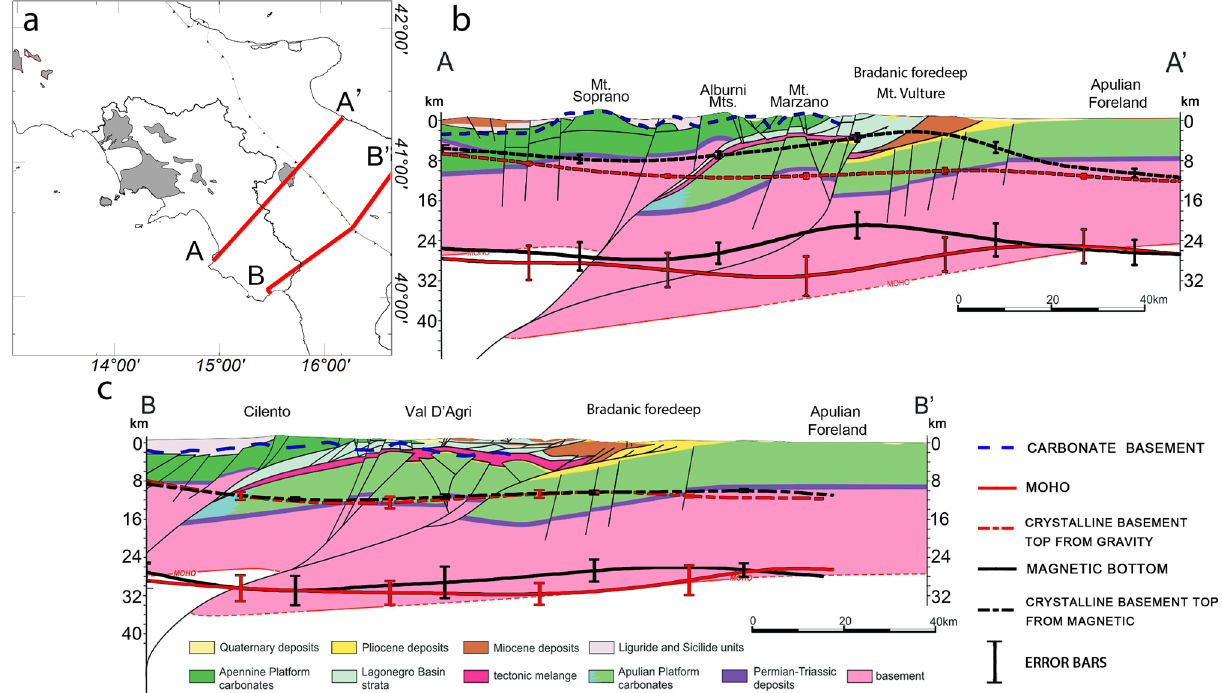
Figure 9. Crustal sections across the Southern Apennines (modified after 100 ). Section A-A ′ is along the trace of the CROP 04 deep seismic reflection profile. The carbonate basement top and spectral depth estimates are superimposed for